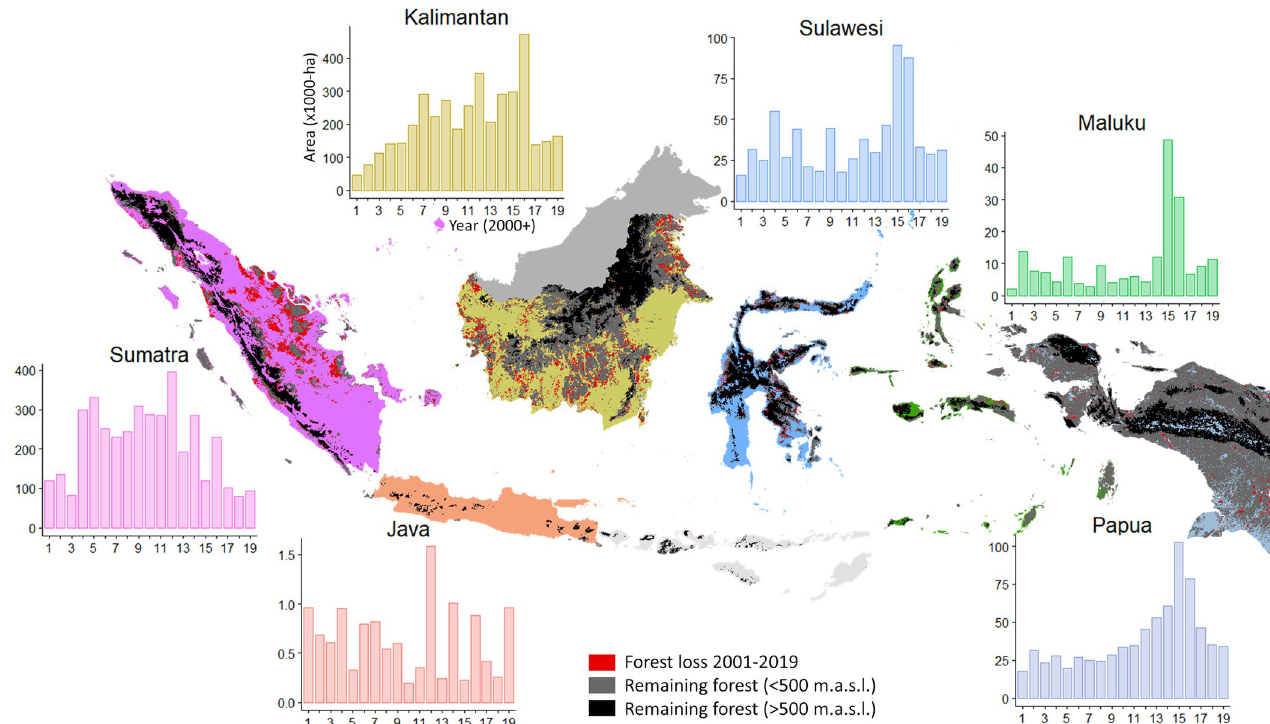
Fig 4. Deforestation from 2001 to 2019 and remaining forest in 2019 by Indonesian region. Y-axis represent areas (in 1000-ha, note different scales) of forest cleared each year.